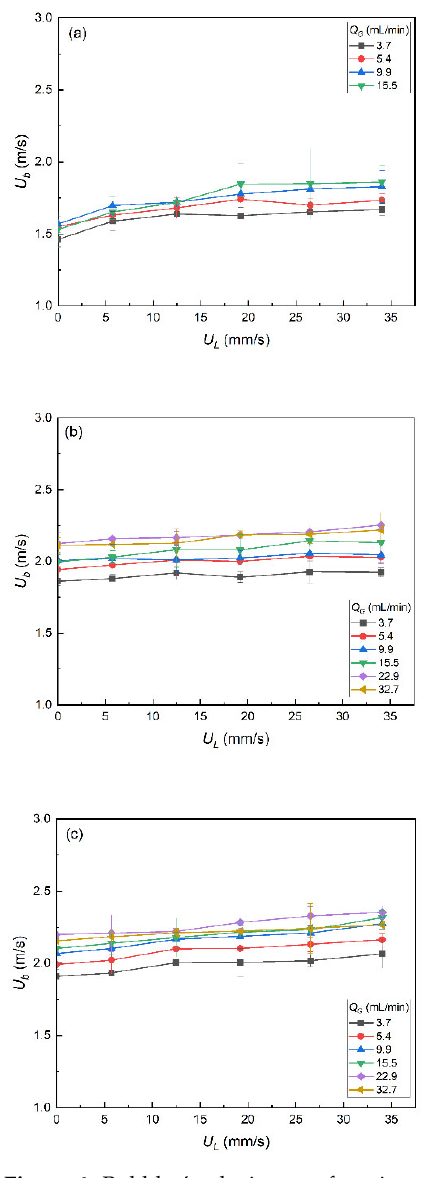
Figure 6. Bubbles’ velocity as a function of liquid velocity, U L for the different gas flowrates, Q G . Subfigures correspond to the three different orifice sizes of ( a ) d G = 50 µ m, ( b ) d G = 100 µ m and ( c ) d G = 150 µ m.